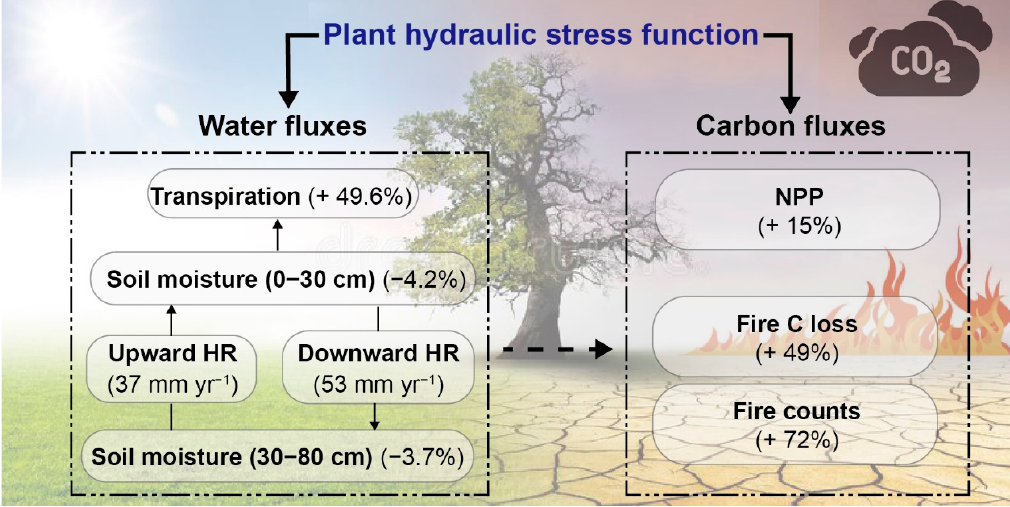
Figure 8. Quantifying the effect of plant hydraulic stress (PHS) function on wildfire regimes, and ecosystem water and carbon fluxes from the global perspective. Each index in the figure were firstly summarized across the globe for simulations with and without PHS configuration (PHS-on and PHS-off), and their increase rates from PHS-off to PHS-on simulations (i.e., 100% ) were calculated.